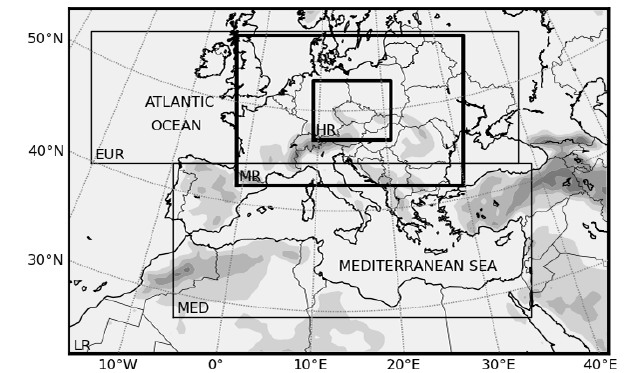
Figure 1. Simulation domain with gray-shaded area indicating a topography higher than 500m. The EUR and MED boxes indicate the regions that will be used below. The Low Resolution domain is the entire map (LR) and the small box inside the EUR box indicate the High Resolution domain